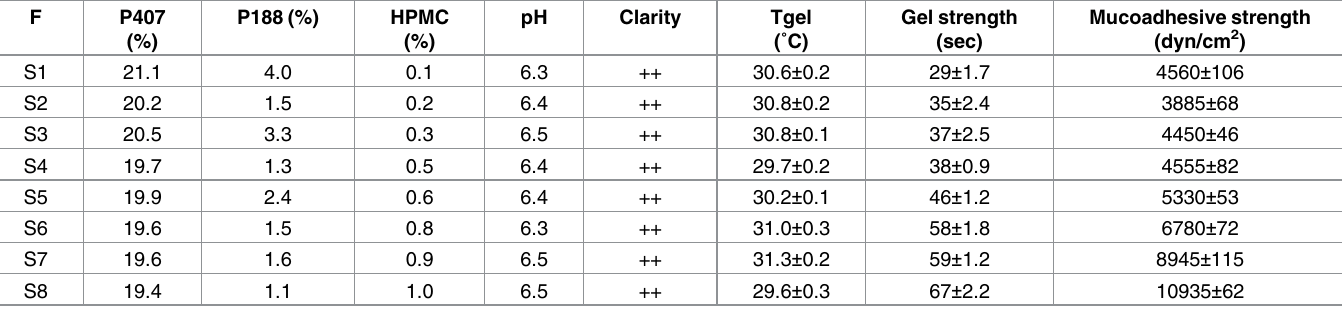
Table 7. Parameters of the optimized formulations (n =